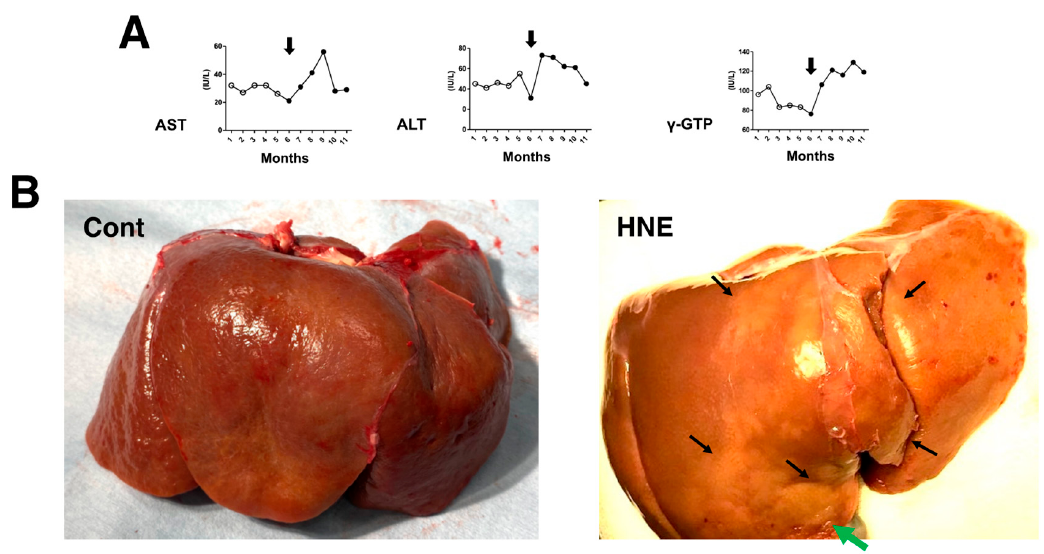
Figure 1. Blood data ( A ) and inspection of the liver at autopsy ( B ). During the 5 mg/week hydroxynonenal (HNE) injections (total dose: 120 mg), the blood analysis showed increased levels of AST, ALT, and γ -GTP (( A ), closed circles), compared to the controls prior to hydroxynonenal injections (( A ), open circles). The surface of the control liver looked diffusely reddish-brown at autopsy (( B ), Cont), while at autopsy 6 months after the initial hydroxynonenal injections, the liver surface of the hydroxynonenal-treated monkeys exhibited heterogeneous, whitish-yellow discoloration (( B ), HNE, black and green arrows) intermingled with dark-brown areas. These whitish-yellow areas histologically exhibited severe degeneration, while the dark-brown area exhibited mild degeneration.